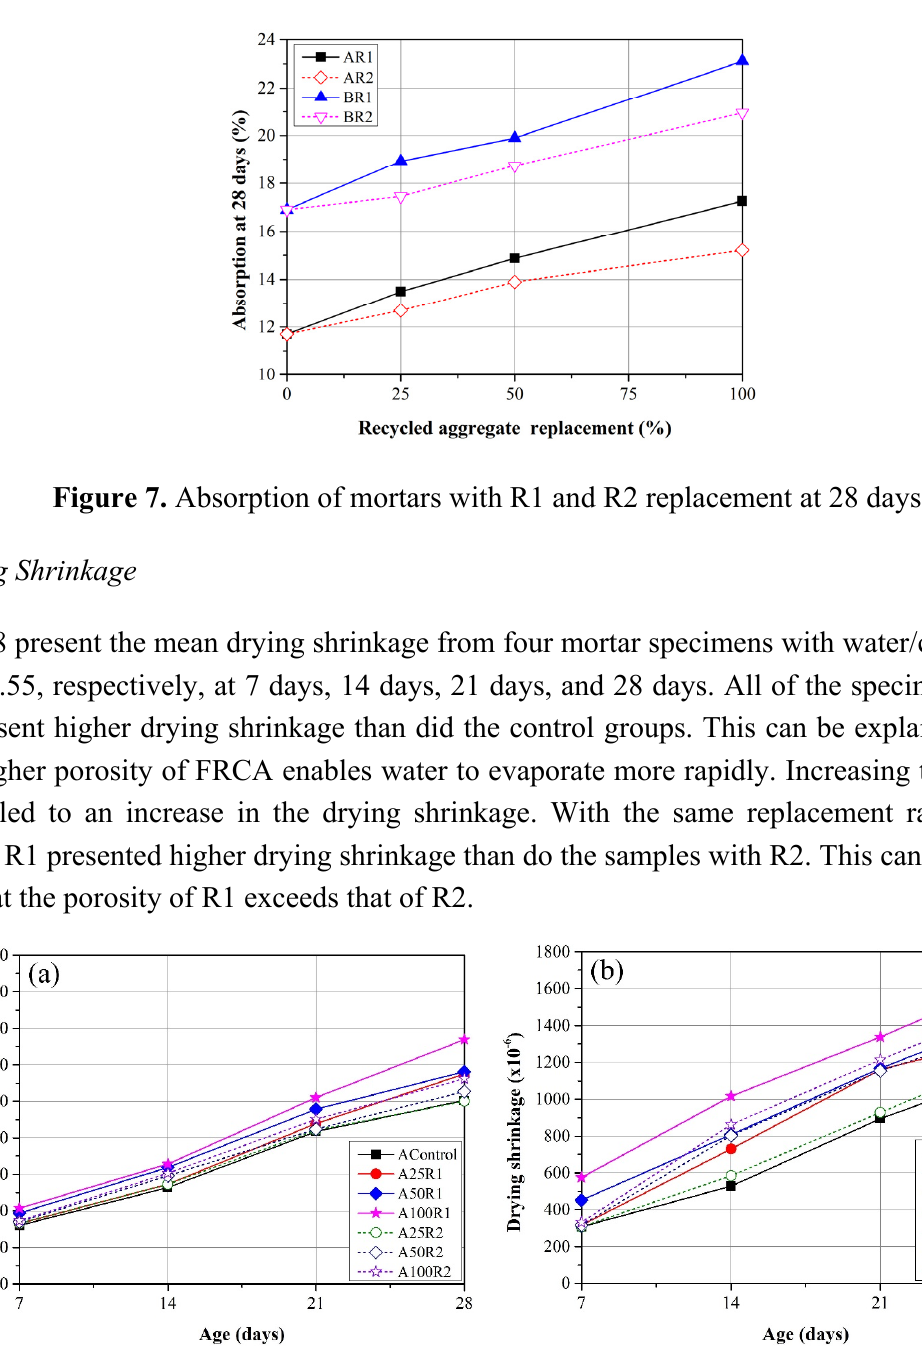
Figure 8. Development of drying shrinkage of mortars with ( a ) W/C = 0.35, and ( b ) W/C =